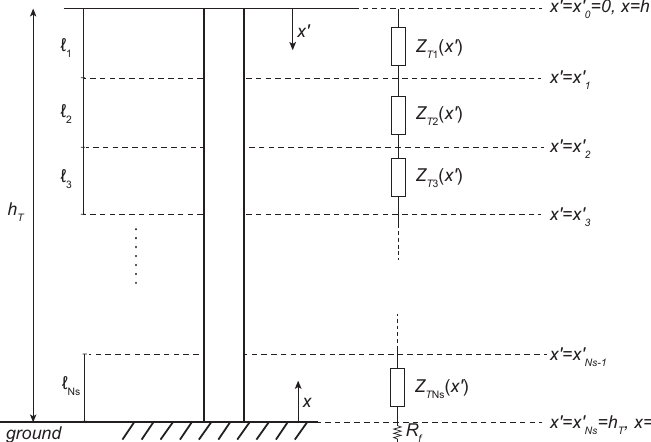
Figure 15. Non-uniform transmission line model of the tower according to Saied, Oufi et al.